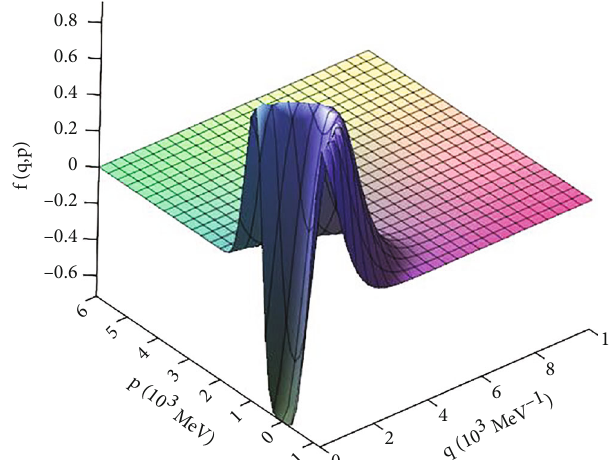
Figure 1: Wigner function for ground state of the c (cid:1) c